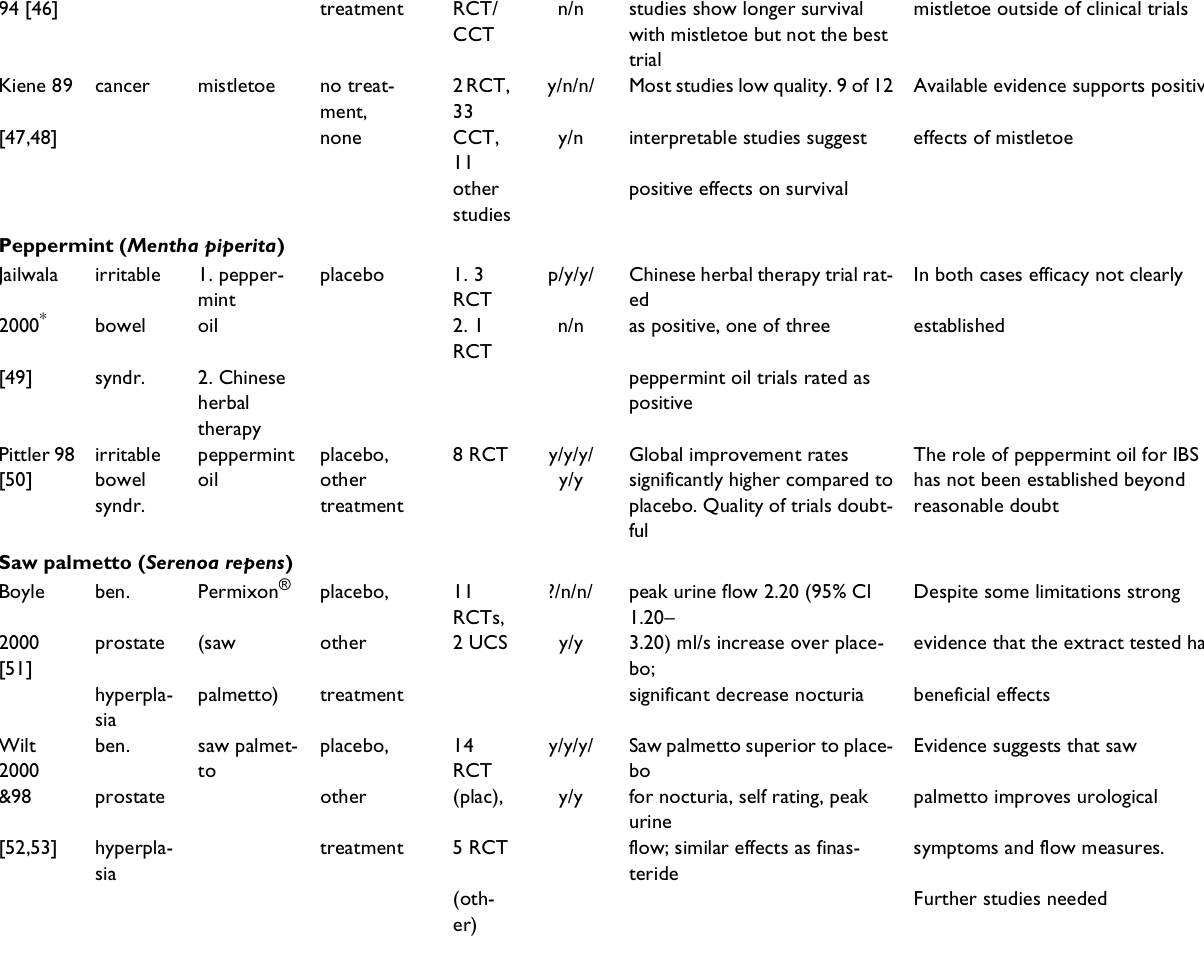
Table 3: Systematic reviews of clinical trials of herbal medicines (at least 2 reviews per herb)